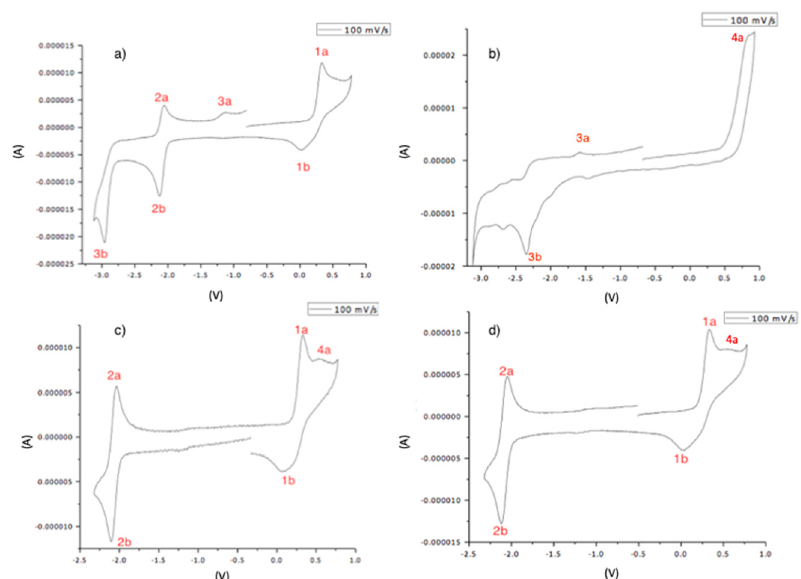
Table 4. Cyclic voltammetric parameter for NiR salen complexes, referenced to the pair Fc + /Fc.